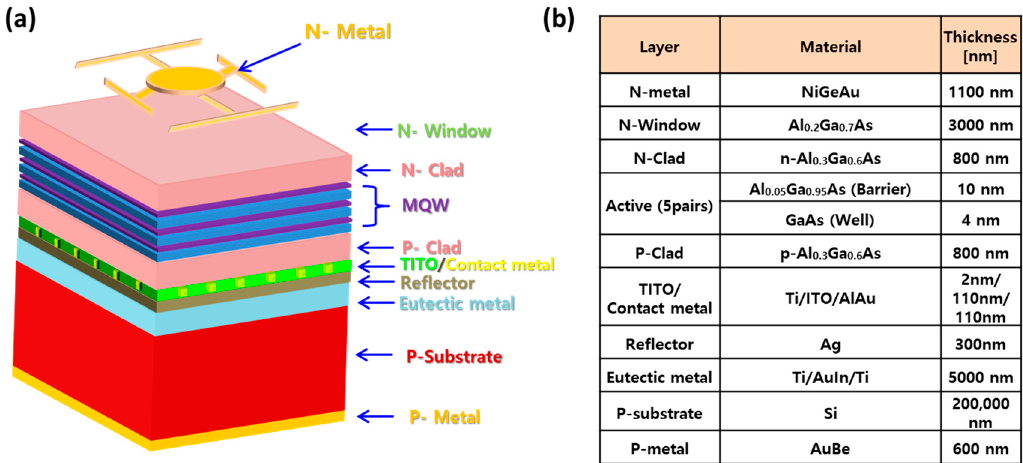
Figure 1. ( a ) Structural schematic and ( b ) composition information of wafer-bonded 850 nm near- infrared light-emitting diodes (NIR-LED).